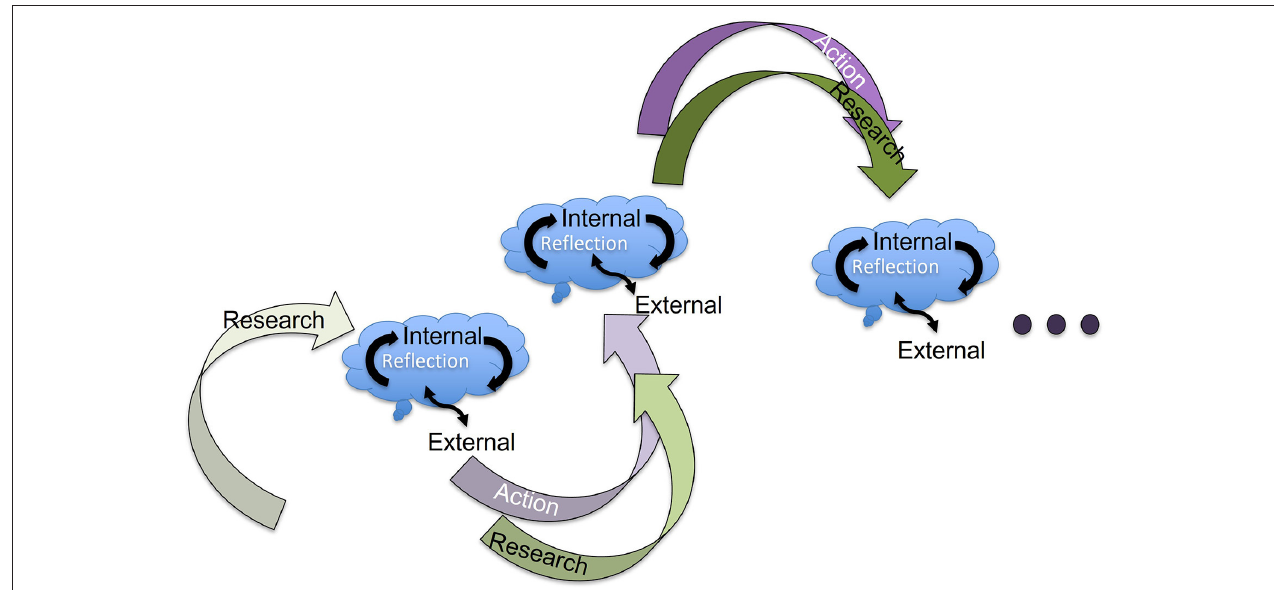
FIGURE 3 | Participatory action research (modified from Méndez et al.,